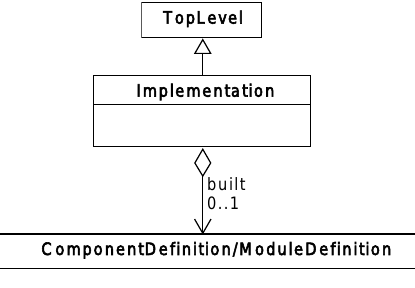
Figure 22: Diagram of the Implementation class and its associated